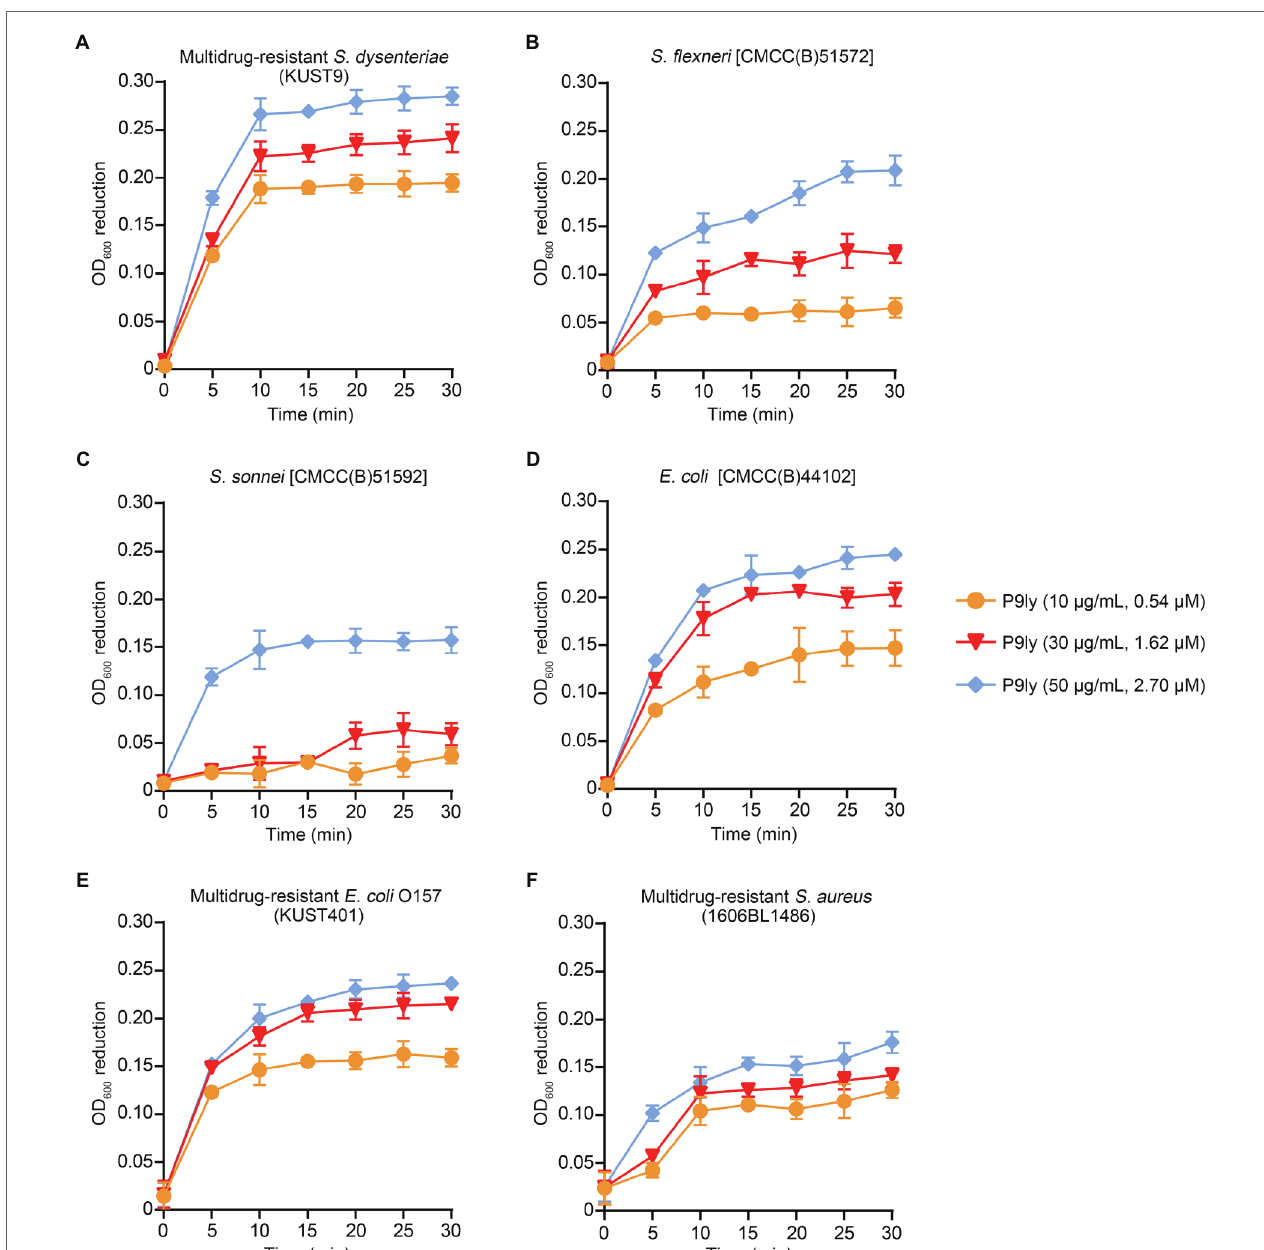
FIGURE 6 | Dependence of P9ly bacteriolytic activity on its concentration. Standard turbidity reduction assays were used to measure the effects of lytic enzyme P9ly under different treatment durations and different concentrations. The various panels in the figure show that P9ly acts on different strains. (A) Multidrug-resistant Shigella dysenteriae (KUST9); (B) Shigella flexneri [CMCC(B)51572]; (C) Shigella sonnei [CMCC(B)51592]; (D) Escherichia coli [CMCC(B)44102]; (E) Multidrug- resistant E. coli O157 (KUST401); and (F) Multidrug-resistant Staphylococcus aureus (1606BL1486). It should be noted that there was a blank measurement subtracted from the assayed values in the experiment. For all strains, OD600 reduction was calculated in comparison with PBS-treated control at each time point. Values are expressed as mean ± SD. The experiment was repeated in